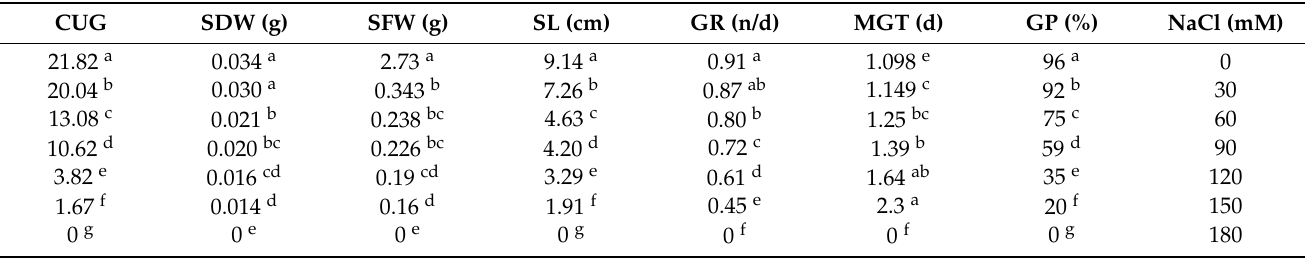
Table 2. Comparisons of GP and GR means and morphological traits of Hibiscus tea seeds at different salt (NaCl) levels.